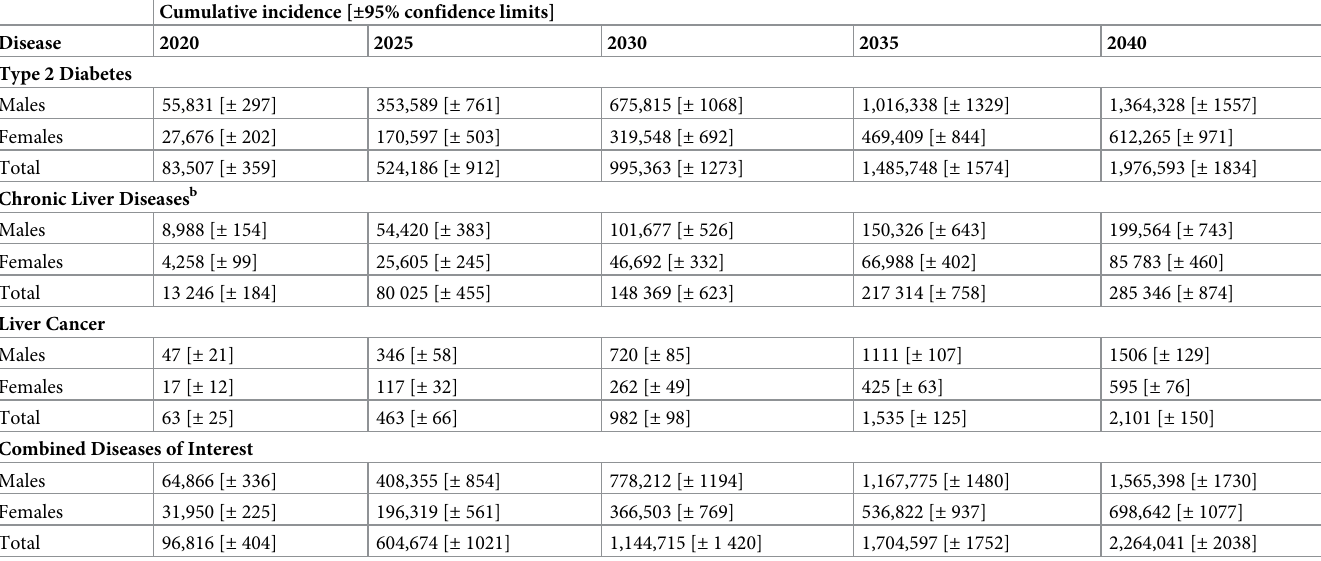
Table 2. Obesity-attributable incidence of type 2 diabetes, chronic liver diseases and liver cancer amongst working-age males and females (20–59 years) in the Saudi Arabian population, 2020–2040. Cumulative incidence [ ± 95% confidence